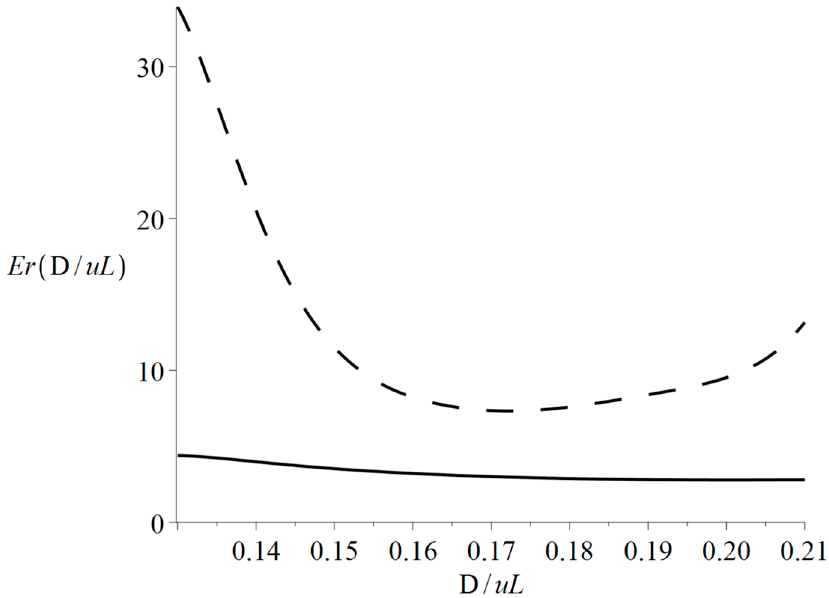
Figure 3. The errors for the classical solution (dashed line) versus the new solution (solid line).